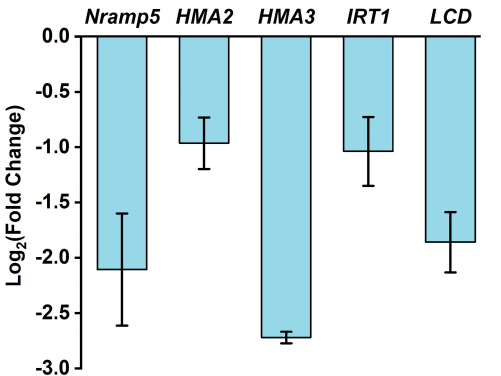
Figure 9. The results of gene expression in roots at the filling stage (5 September 2020) showing that HNW could decrease cadmium accumulation. Transcripts of Nramp5 , HMA2 , HMA3 , IRT , and LCD were analyzed by qPCR. Data are mean ± SD (n = 3).